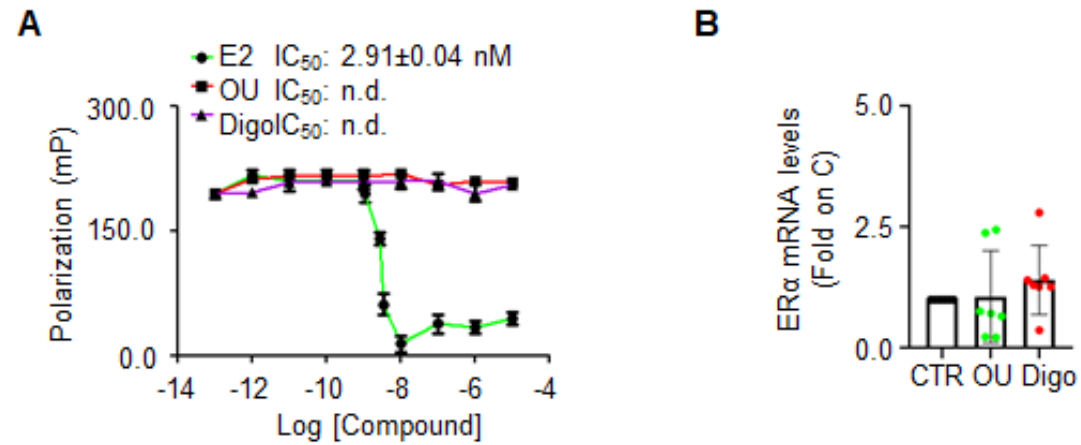
Figure 6. Impact of ouabain and digoxin on ER α binding and mRNA expression. ( A ) In vitro ER α competitive binding assays for ouabain (OU—red), digoxin (Digo—purple), and 17 β -estradiol (E2—green) performed at different doses, using a florescent E2 as a tracer. Inhibitor concentration 50 (IC 50 –nM) is indicated in the panel, for each compound. The experiment was performed in quintuplicates. ( B ) Real-time qPCR analysis of ER α mRNA levels in MCF-7 cells, treated for 24 h with ouabain (OU—100 nM) and digoxin (Digo—100 nM). The experiment was repeated seven times.